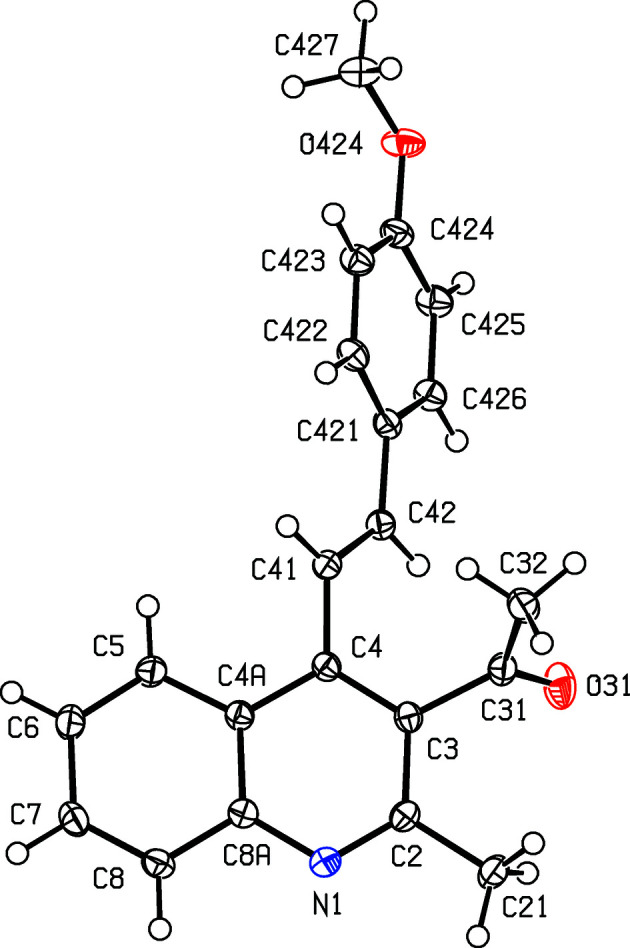
The mol­ecular structure of com­pound (I), showing the atom-labelling scheme. Displacement ellipsoids are drawn at the 50% probability level.